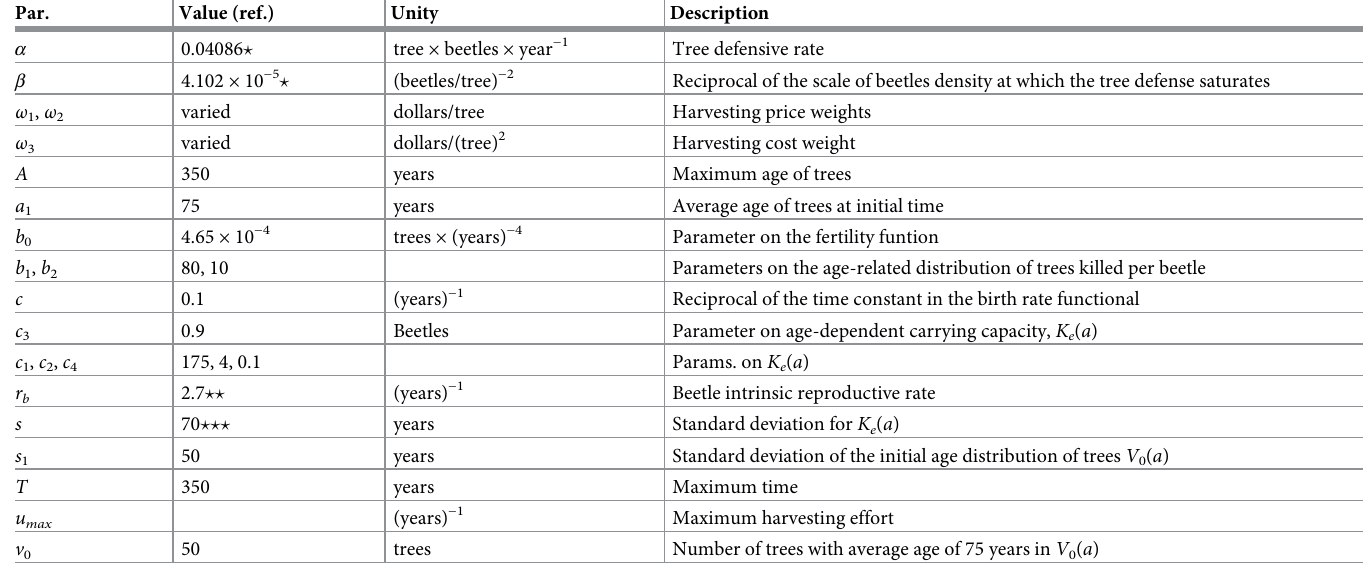
Table 1. Parameters and values used in the model and numerical simulations. A few bibliographic references are used [55] (denoted by ? ), [60] (denoted by ?? ), and [48] (denoted by ??? ). Par. Value